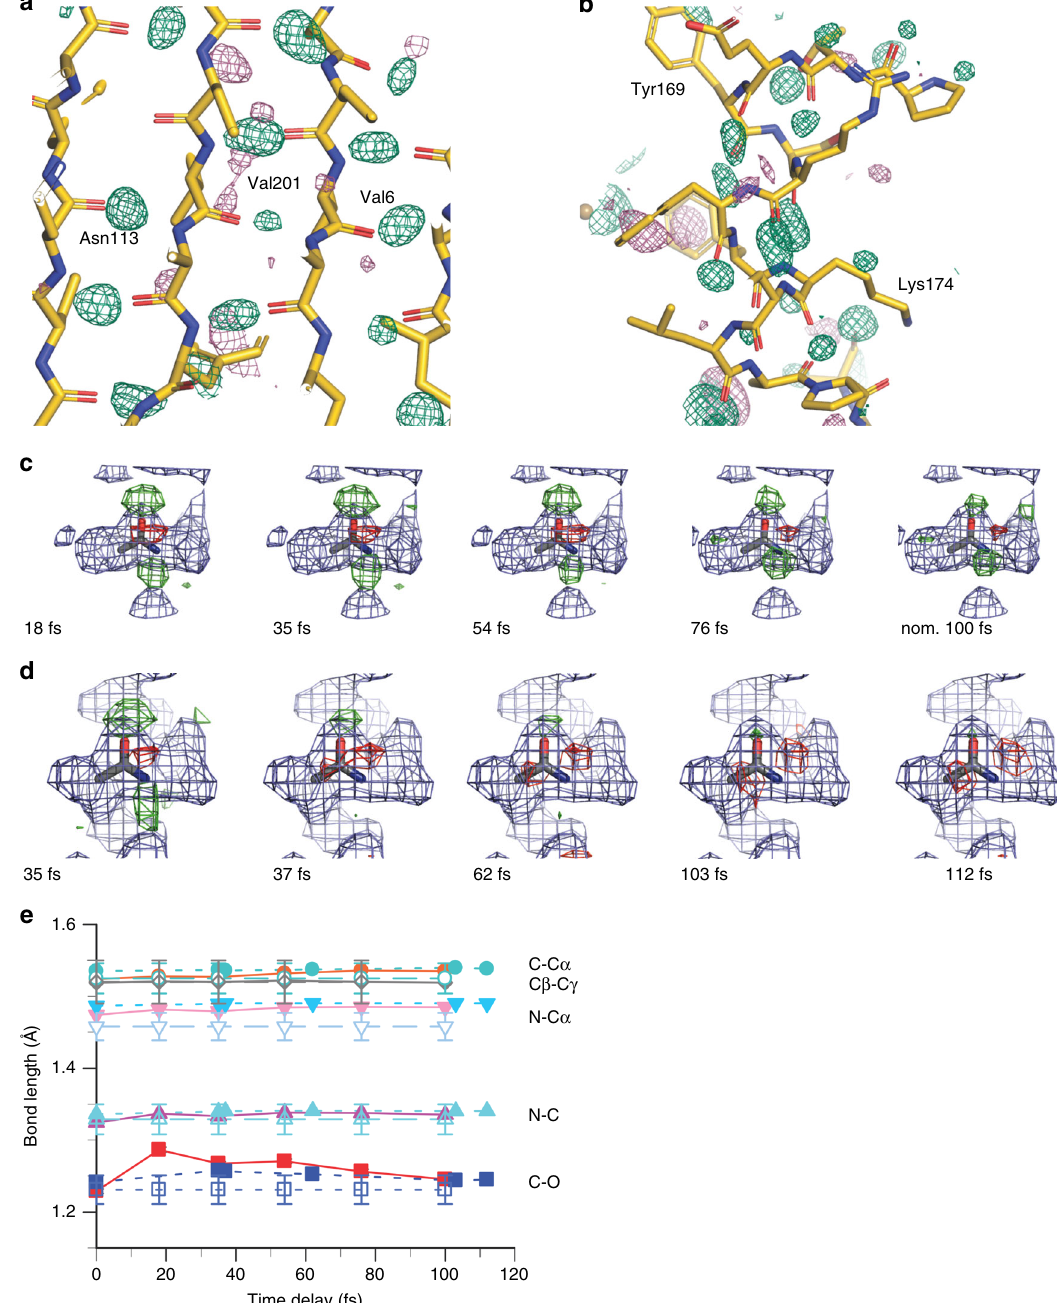
Fig. 2 Changes in the protein backbone. a , b Isomorphous difference density map (F obs(18fs) – F obs(single pulse) ) 29 of thaumatin at a contour level of + 3 σ (green) shows peaks close to carbonyl oxygen atoms involved in hydrogen bonds in the ß-sheet region ( a ) and the ɑ -helix region ( b ). There are fewer negative ( − 3 σ pink) than positive ( + 3 σ green) difference peaks. c , d Isomorphous difference density maps (F obs( Δ t) – F obs(single pulse) ) of thaumatin ( c ) and lysozyme.Gd ( d ) averaged over all peptide bonds shows also negative peaks ( − 3 σ (red) and + 3 σ (green)). Both proteins show the effect, but it is less dependent on the delay time in case of lysozyme.Gd. This may be due to data quality; the lysozyme.Gd data deteriorate much faster than those of thaumatin (Supplementary Figs. 2 – 4, Supplementary Tables 1 and 2). e Re fi ned bond lengths of the peptide bonds in lysozyme.Gd (blue fi lled symbols) and thaumatin (red fi lled symbols). The bond lengths are average values of 100 independently re fi ned structures using a jackknife approach. The values of standard bond lengths 60 are displayed using open